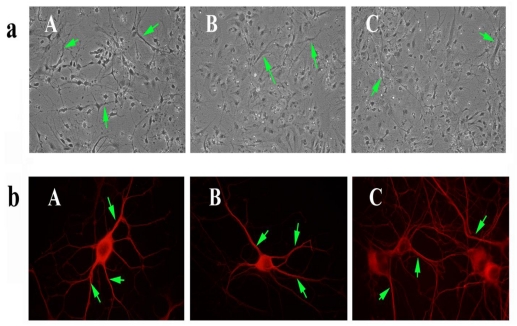
Primary neurons from mice pretreated with SS31 and then with picloram (B) and triclopyr (C). The neurons exhibited intact projections/network, similar to those in the untreated neurons (A). Image a shows primary cortical neurons and photographs taken with a phase-contrast microscope at 20x the original magnification. Image b shows immunofluorescence analysis of the beta III tubulin antibody in primary hippocampal neurons pretreated with 1 nM SS31 and then treated with 5 mM picloram (B) and 3 mM triclopyr (C). Pretreatment with SS31 prevented neuronal damage caused by picloram and triclopyr. Photographs were taken using a fluorescence microscope at 100x the original magnification. Green arrows indicate intact/healthy neurons, and white arrows, degenerative neurons.